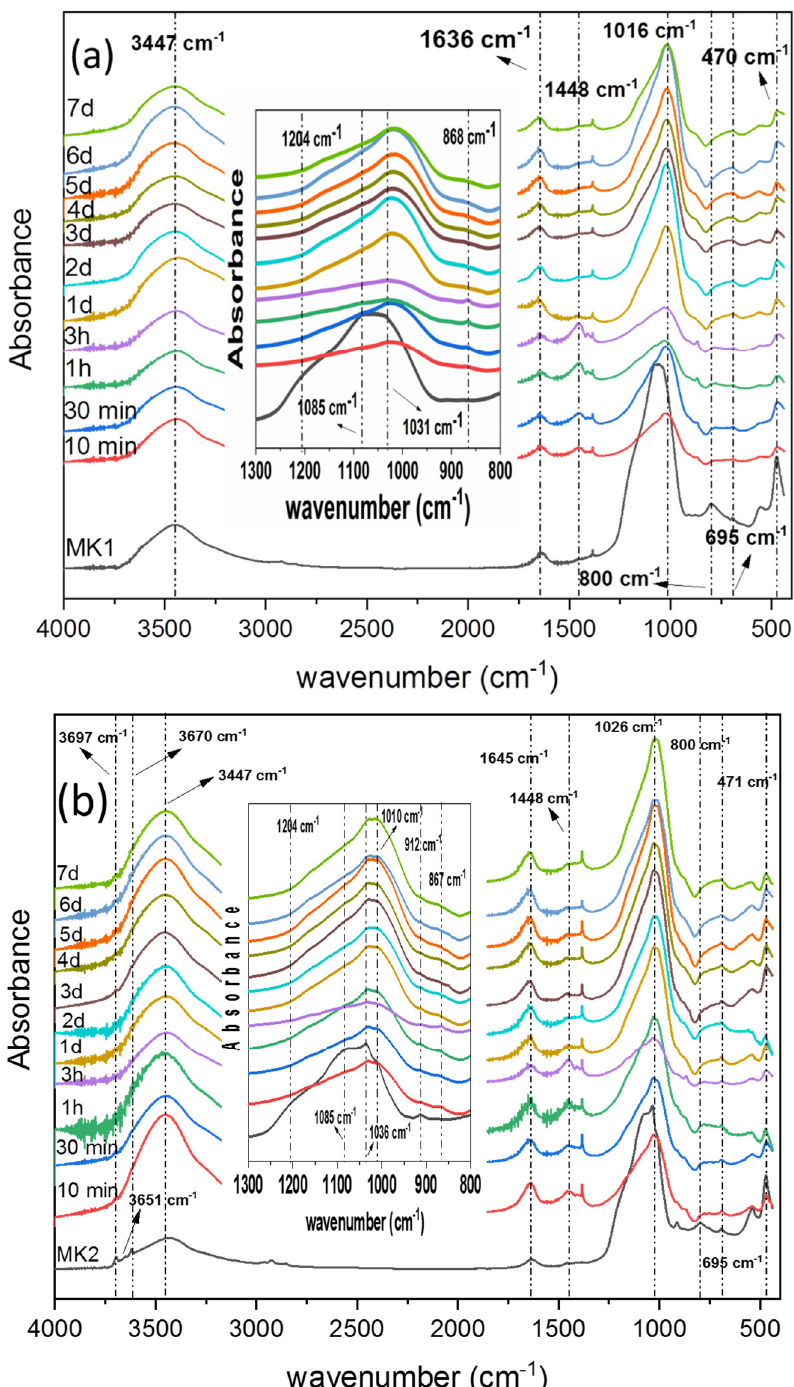
Figure 5. Infrared absorption spectra for samples ( a ) MK1 and ( b ) MK2, as a function of geopoly- merization reaction. The main absorption bands are highlighted. Insets: magnification of the region between 1300 and 900 cm −1 .